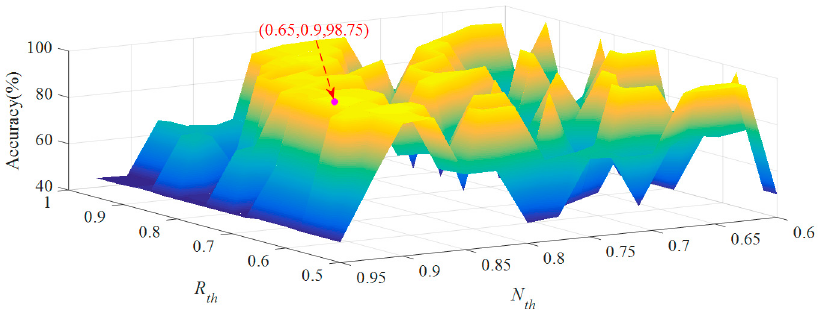
Figure 10. Relationship between accuracy and two key parameters.